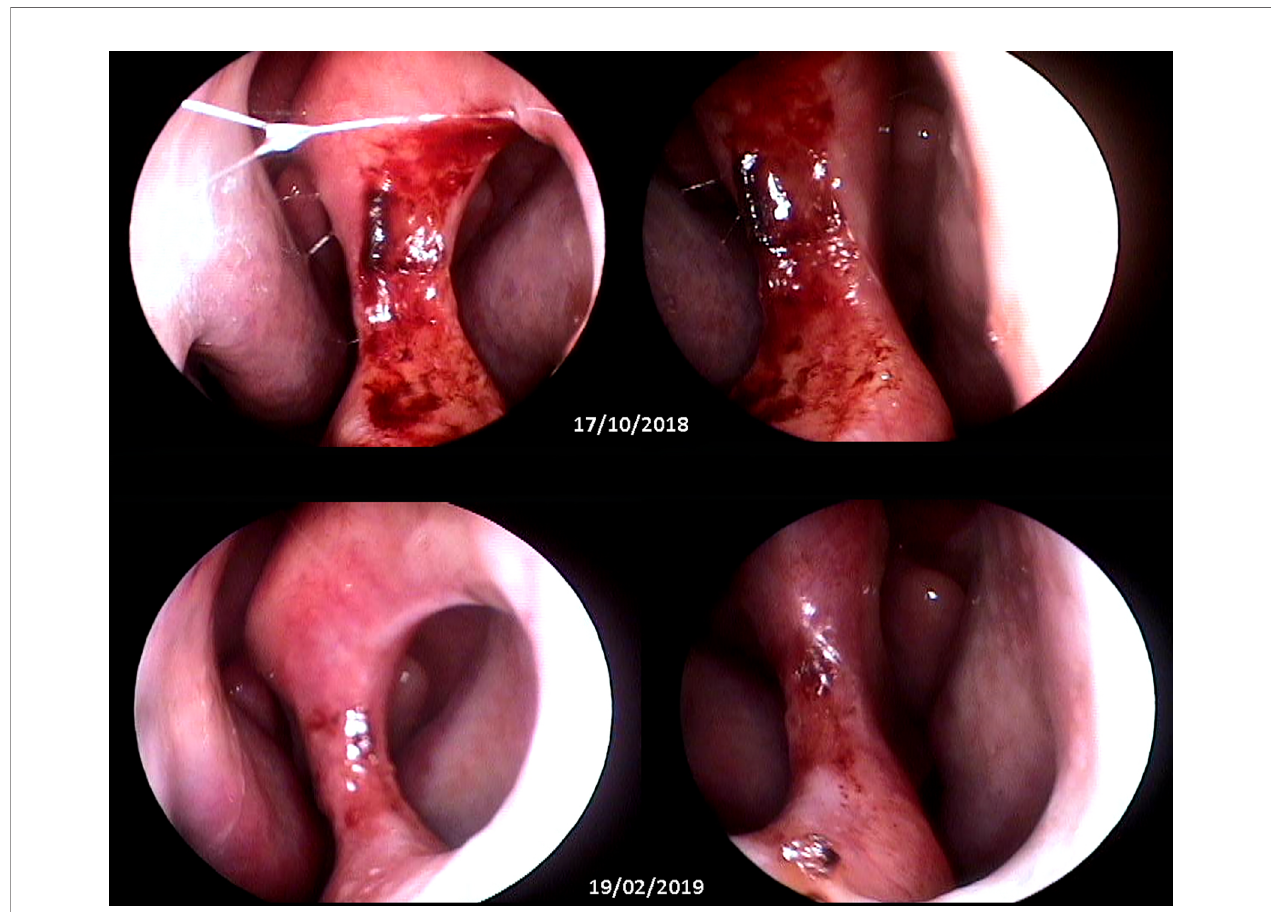
FIGURE 2 | Top: wide septal perforation with in fi ltrated borders and granulomatous ulcerated aspect (pretreatment). Bottom: septal perforation with smooth borders without ulceration and with cicatricial aspect (90 days after treatment). Images obtained with naso fi broscopy and provided by Dr. Gustavo